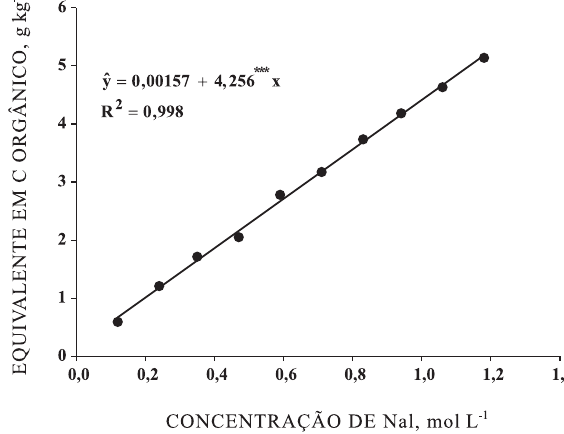
Figura 3. Equivalente em C orgânico determinados por oxidação por via úmida, em soluções isentas de C, com concentrações crescentes de